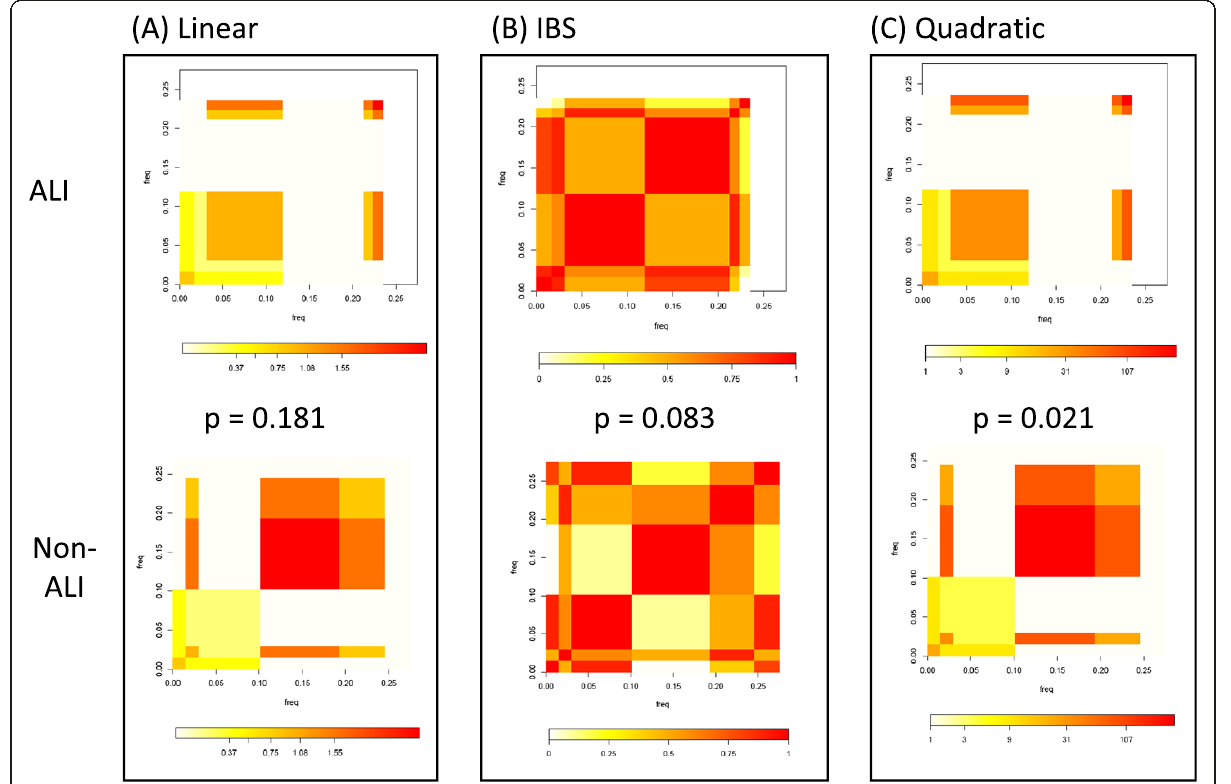
Figure 4 Representative kernel matrix plot of the IL10 gene in AA subjects. For each matrix, the ALI or non-ALI population of haplotypes is plotted against itself according to the kernel function. Each cell on the matrix reflects the extent of haplotype sharing between ALI subjects or non-ALI subjects. The cell size reflects the frequency of the haplotype, such that common haploypes are larger rectangles. The color reflects the kernel function value for each haplotype among ALI or non-ALI; more intense red coloration reflects a higher degree of similarity between pairs of subjects based on their diploid genotypes. Comparing the top and bottom plots in each box, one observes that the ALI (top) plots are distinct for each kernel function, but the plots are most discordant for the quadratic function, which allows for 2-way interactions between SNPs within the haplotype block to inform the association. Accordingly, the p- value for the quadratic kernel test with ALI was the most statistically